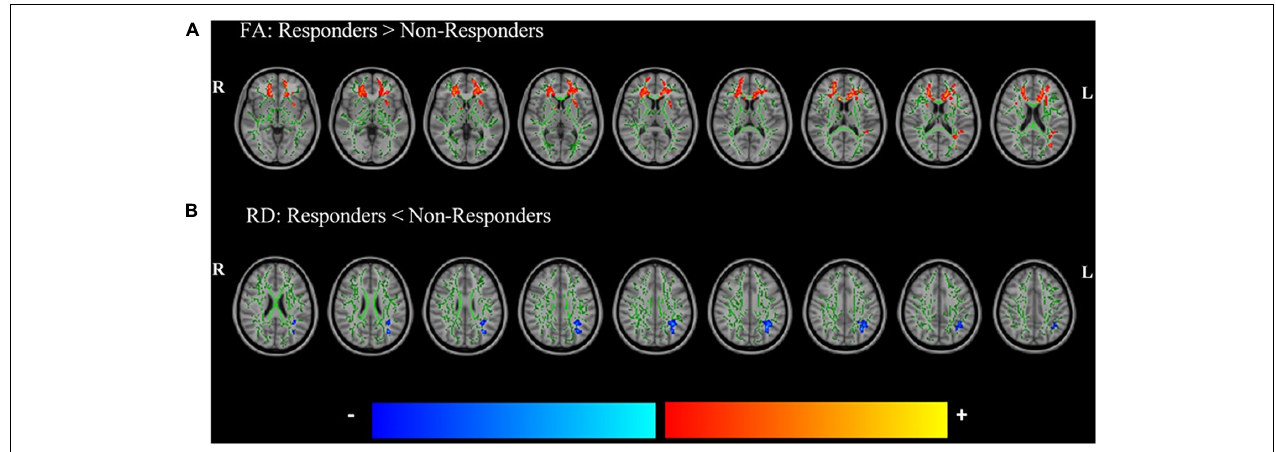
FIGURE 2 | Significant differences in the fractional anisotropy (FA) (A) and radial diffusivity (RD) (B) maps between future responders and non-responders to paroxetine treatment controlled for time between assessments, age, and sex. Responders had increased FA and decreased RD compared to non-responders. Red – yellow voxels indicate a significant increase in FA, whereas blue – light blue voxels indicate a significant decrease in RD in future responders compared with non-responders to paroxetine treatment. Significance threshold was set to p < 0.05 [family wise error (FWE) corrected for multiple comparisons]. The white matter (WM) skeleton (represented in green ) is superimposed on a T1-weighted Montreal Neurological Institute (MNI)